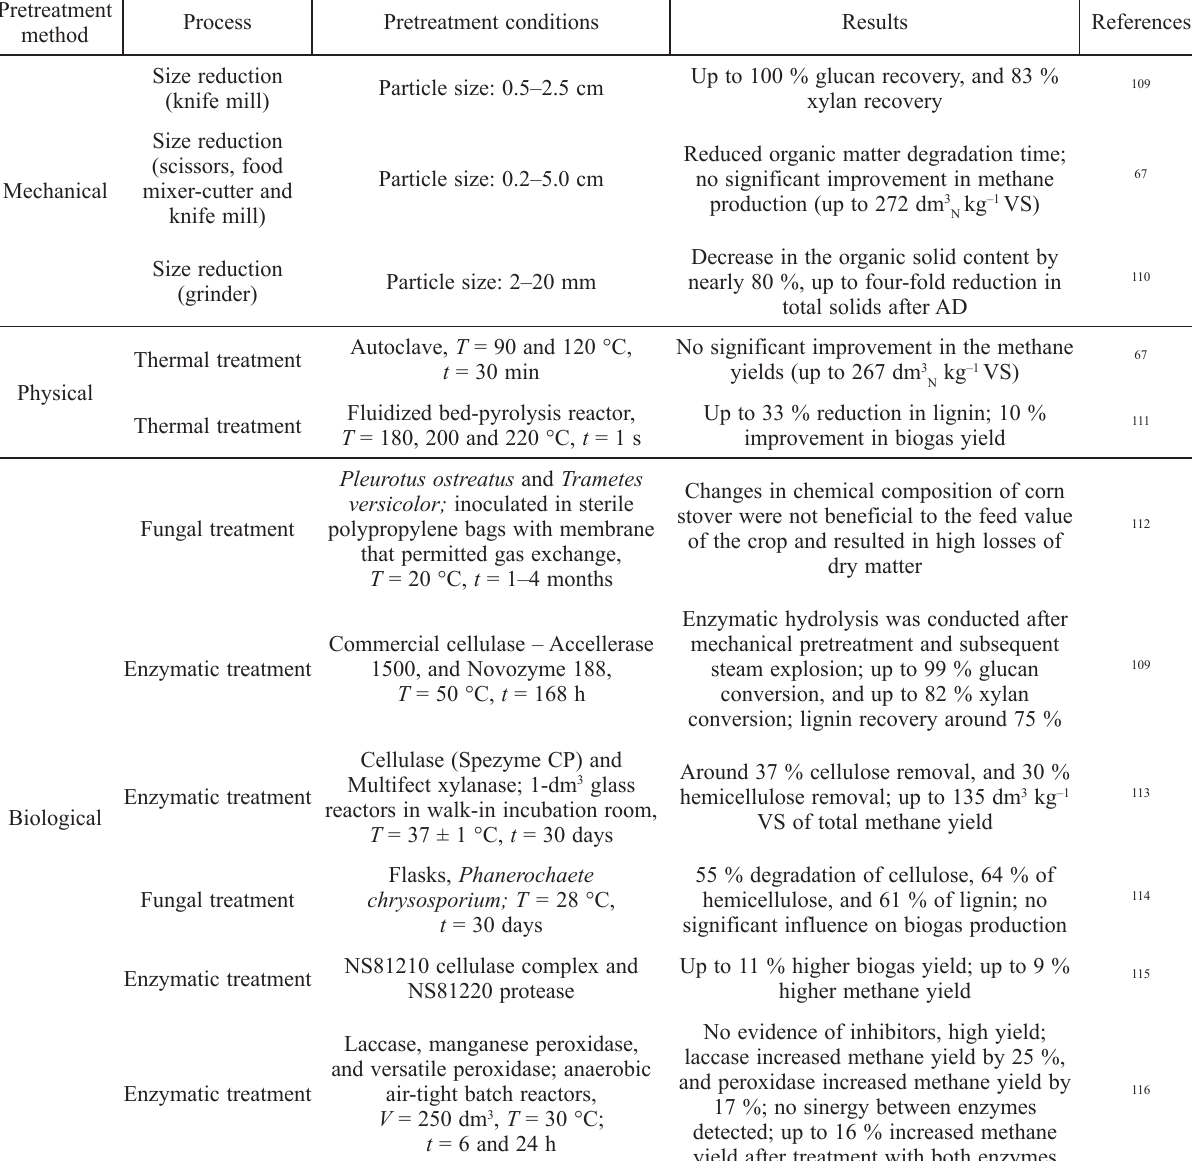
Table 5 – Literature review of research for corn stover pretreatment